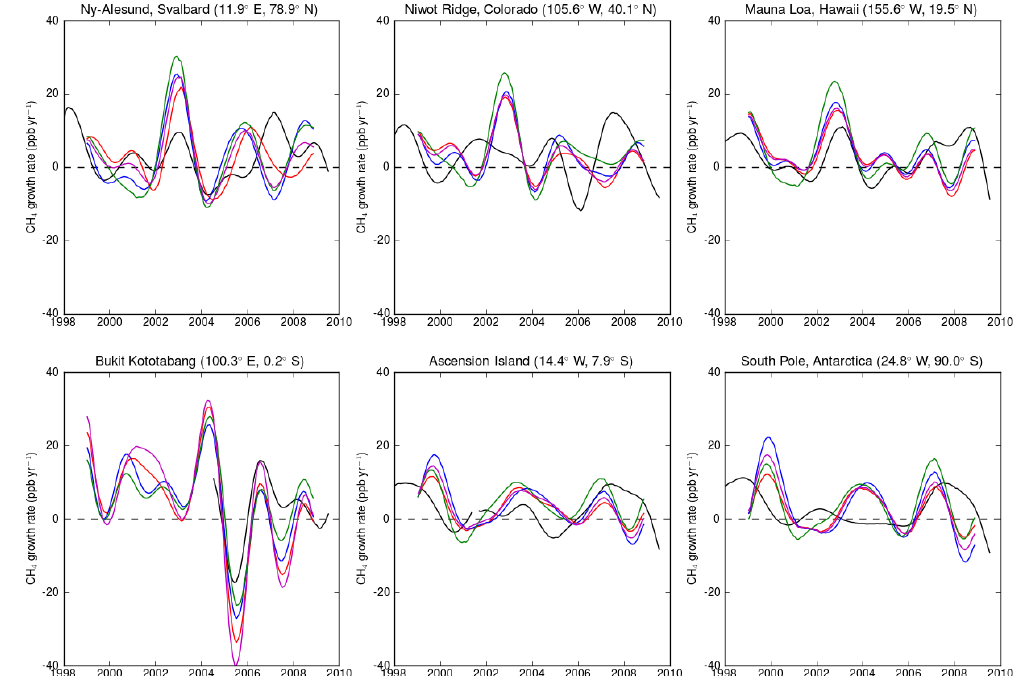
Figure 6. Comparison of the growth rates in the surface atmospheric methane mixing ratio (in ppb) as observed (black) and from the HadGEM2 runs using the following wetland emission inventories, FUNG (red), TRANSCOM FUNG (magenta), JULES (blue) and JULES- GIEMS (green) at selected sites between the years 1998 and 2010.